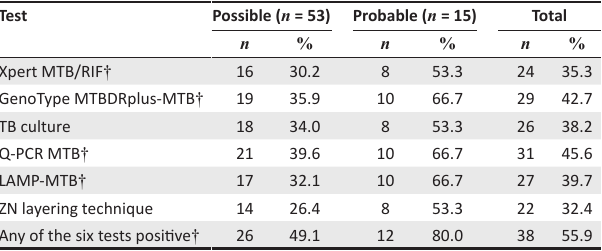
TABLE 1: Frequency of positives in the probable and possible groups using the uniform case